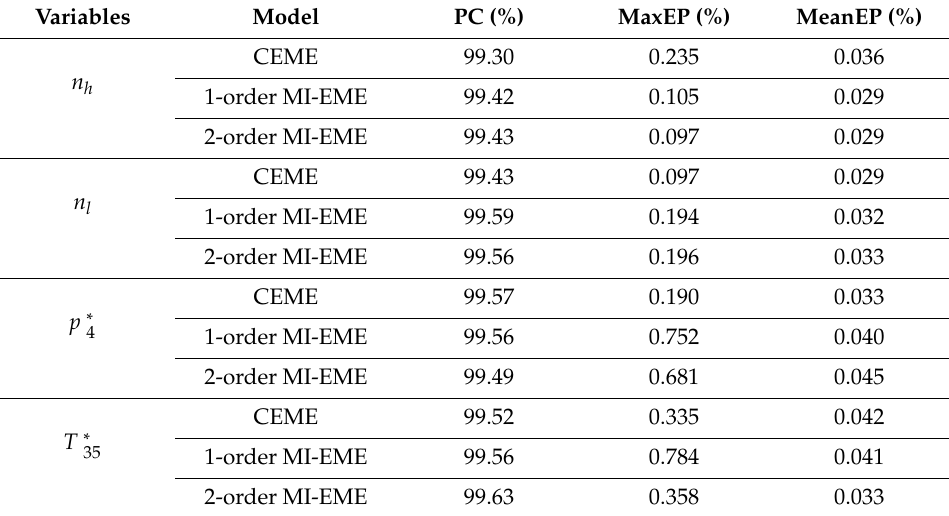
Figure 14. ( a ) n h variations in training set; ( b ) n l variations in training set; ( c ) T ∗ Figure 14. ( a ) 𝑛 (cid:3035) variations in training set; ( b ) 𝑛 (cid:3039) variations in training set; ( c ) 𝑇 (cid:2871)(cid:2873)∗ variations in set; ( d ) p ∗ variations in training set. training set; ( d ) 𝑝 (cid:2872)∗ variations in training set. 4 Table 3. Performance comparison of the examined